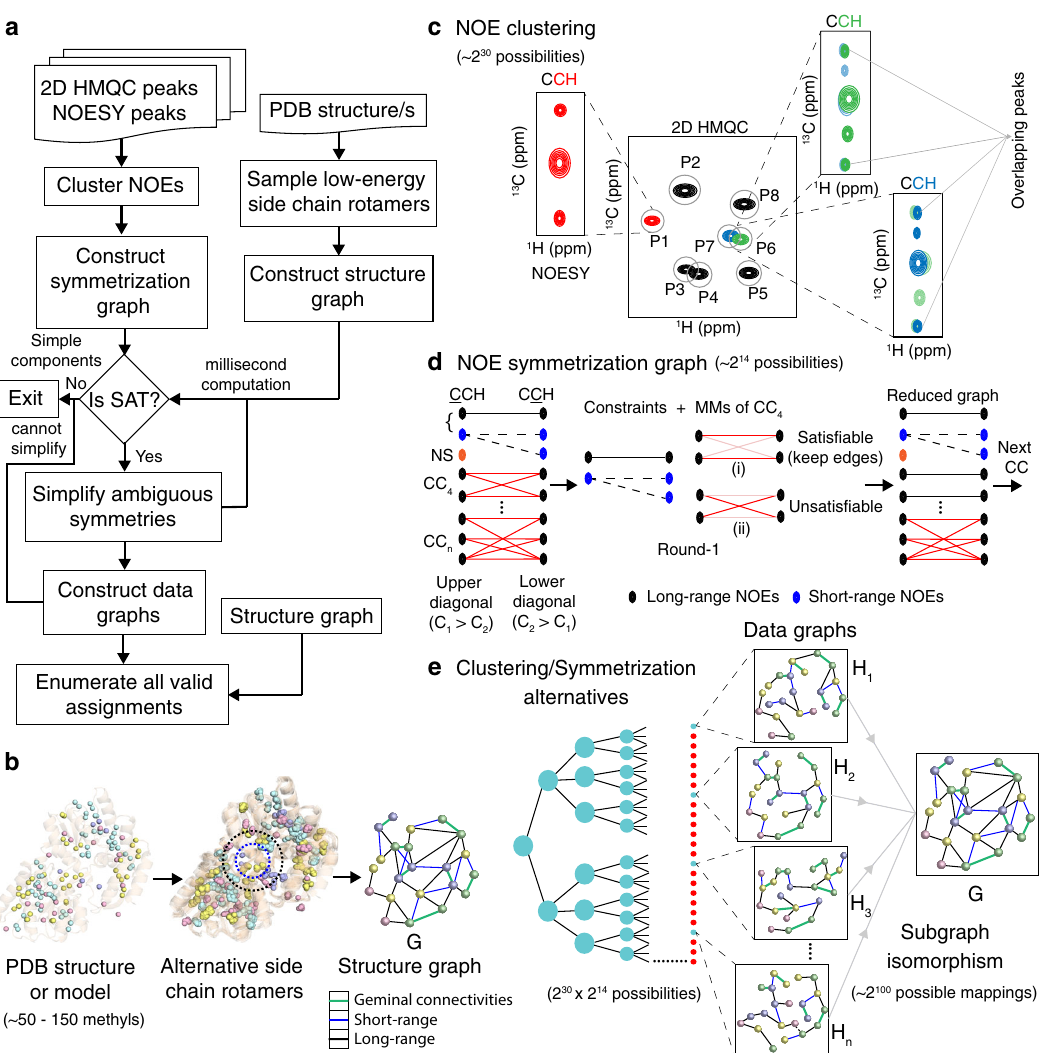
Fig. 1 Exhaustive enumeration of methyl assignments from raw NOE peaks. a Iterative work fl ow of the MAUS system. b Description of a structure graph, G with (~50 – 150) methyls as nodes. The edges of G correspond to all possible short-range (blue; up to 6 – 8 Å), long-range (black; from 6 up to 10 Å), and geminal methyl connectivities (green). c The 2D projections of 3D or 4D NOESY peaks are clustered (within tolerances; gray circles) to 2D HMQC reference peak positions (P1 … P8). A NOESY peak can be clustered uniquely (red) or ambiguously (green and blue; overlapping peaks), leading to ~2